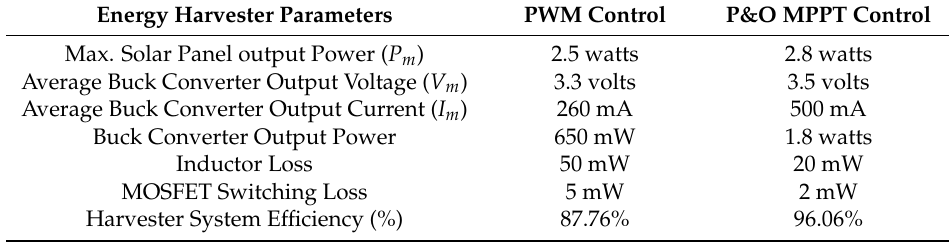
Table 2. Simulation Results for PWM and MPPT Controlled SEH systems.